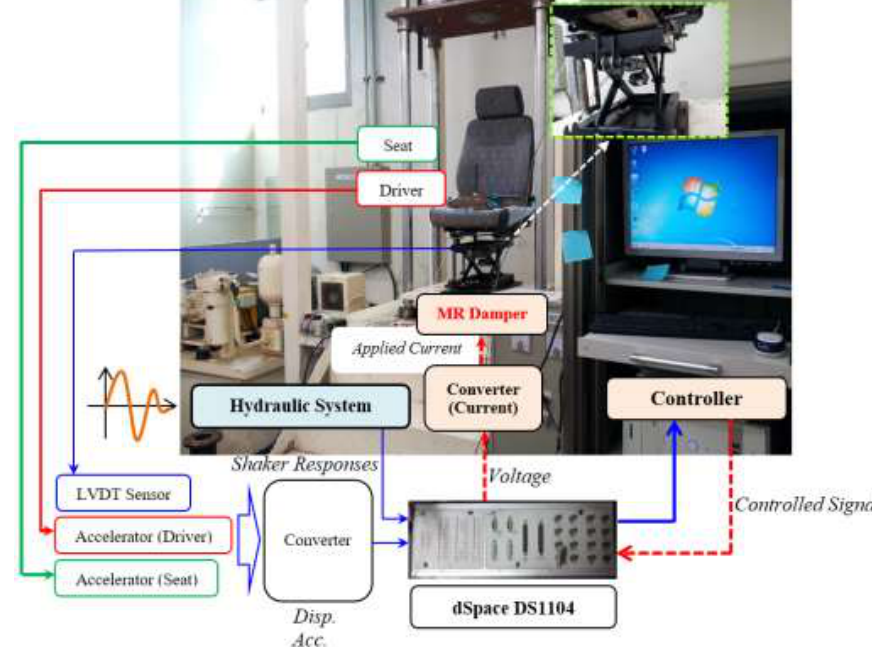
Figure 6. Experiment setup of seat suspension with MR damper for a commercial bus.